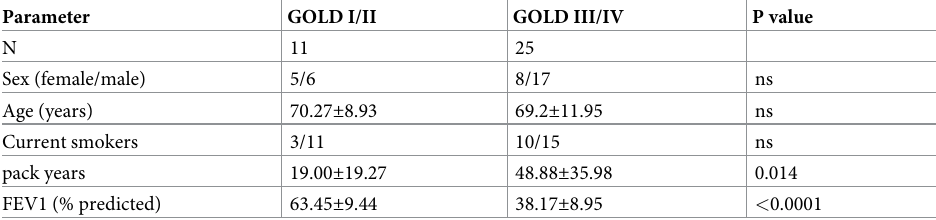
Table 1. Patient